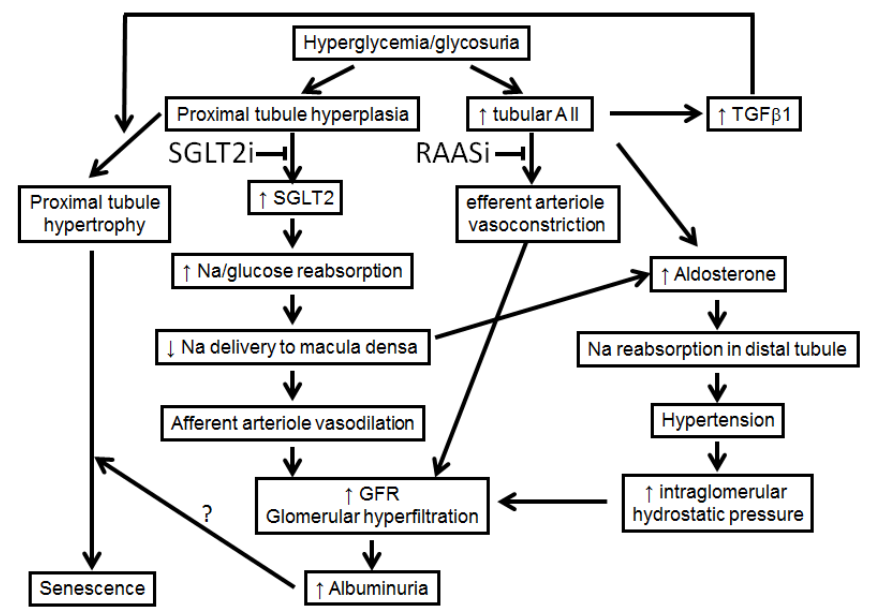
Figure 2. SGLT2 inhibitors and RAAS blockers are required to control glomerular hyperfiltration and albuminuria in diabetes. SGLT2 inhibitors reverse afferent arteriole vasodilation thanks to their proximal natriuretic effect, while RAAS blockers induce efferent arteriole vasodilation. The resulting drop in intraglomerular pressure decreases the GFR in the short term, but is paramount to long-term nephroprotection. AII: angiotensin II, SGLT2: sodium–glucose cotransporter-2